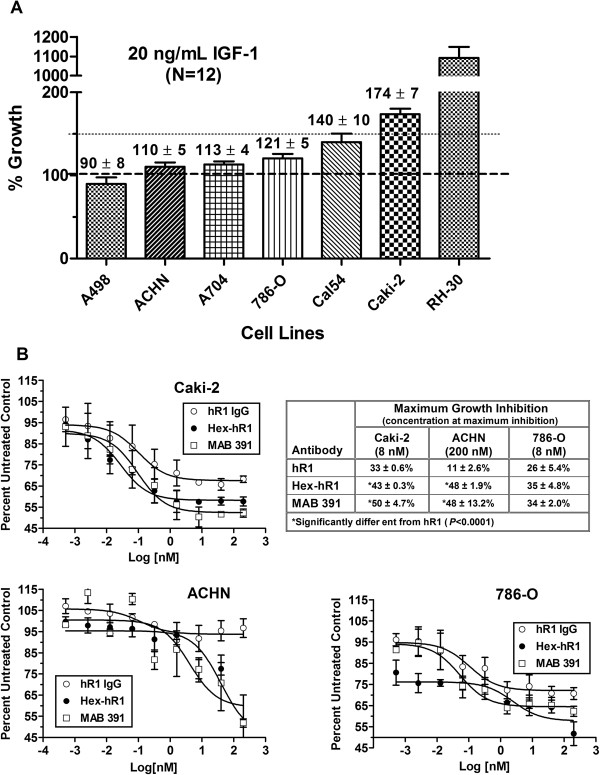
In vitro sensitivity to anti-IGF-1R treatment. (A) Various RCC cell lines were plated in 96-well plates overnight in SFM media before being stimulate with 20 ng/mL of IGF-1. Cells were incubated a further 96 h before cell viability determined as described in Materials and Methods. Growth relative to cells grown only in SFM are shown in the graph. Large dotted line indicates growth of cells in SFM while smaller dotted line indicates point of 50% increase in growth. RH30 served as a positive control cell line. (B) In vitro cytotoxicity assay was run as described in Materials and Methods and compared hR1, Hex-hR1, and positive control MAB391. After 96-h incubation, growth as a percent of untreated cells is shown in the graphs. The table shows maximum growth-inhibition achieved in the various cell lines with each antibody and the concentration required to achieve that inhibition. Data are shown as mean ± standard deviation.